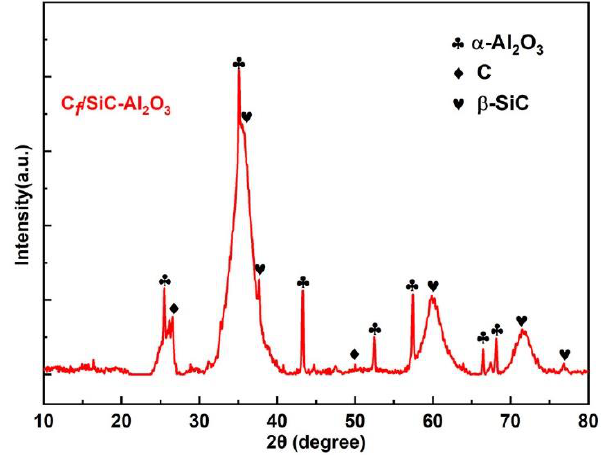
Figure 3. XRD patterns of the matrix for the C f /SiC-Al 2 O 3 composite in a range of 2θ between 10° and 80°.